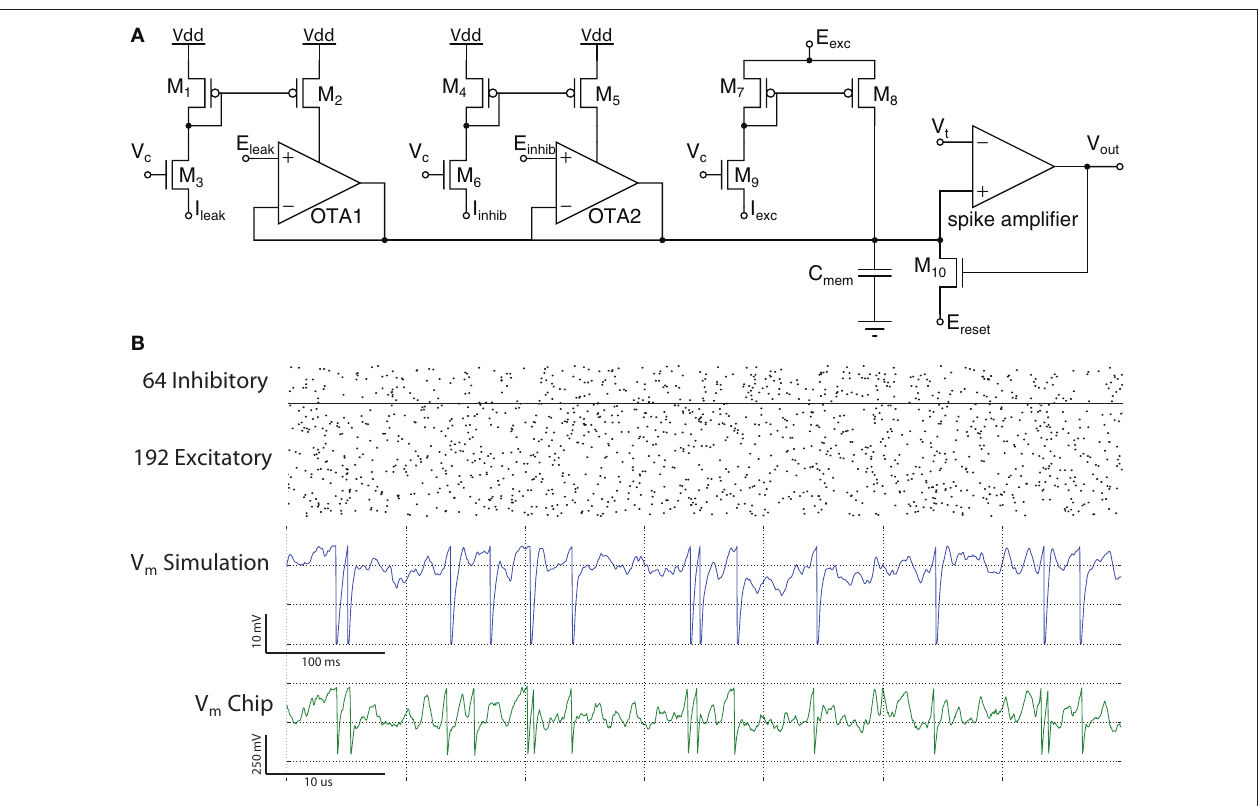
to an equivalent software simulation. The chip is calibrated to an acceleration FIgure 17 | accelerated current-controlled conductance neuron. factor of 10 4 . Top: input spike trains with 8 Hz mean firing rate in biological (a) Schematic diagram: excitatory and inhibitory synaptic inputs can be time. Middle: membrane voltage calculated with the software simulator NEST connected as an array of current-sinks to the I or I nodes. The passive inhib exc (Eppler et al., 2008). Bottom: membrane voltage recorded from the leak behavior is controlled via the I node. (b) Measured response of the leak hardware membrane potential to 256 Poisson distributed input spike trains, compared